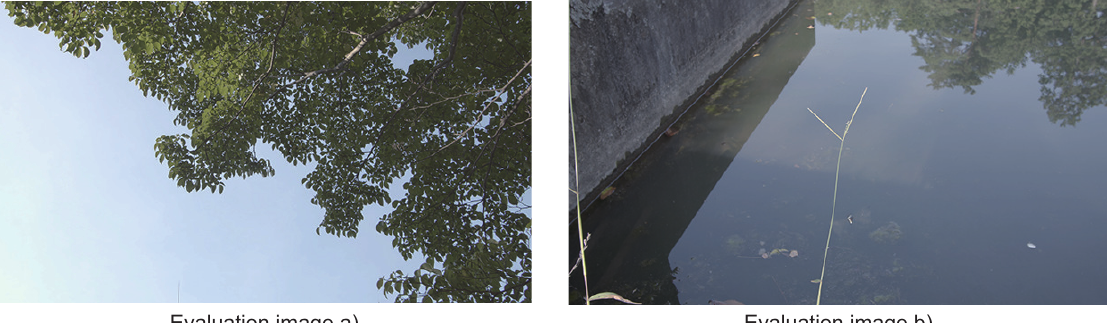
Figure 5. The first frames of two videos used for